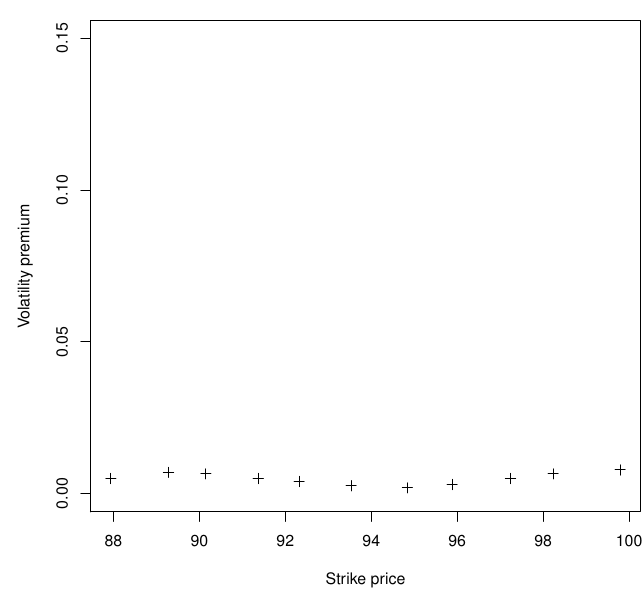
Figure 3. Volatility premium on the 1-month YEN–USD